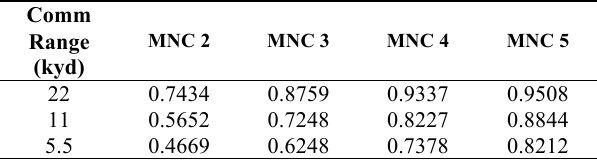
Table 11. Average CPD at 12 Hours of Simulation Time for the Best Cluster Fields